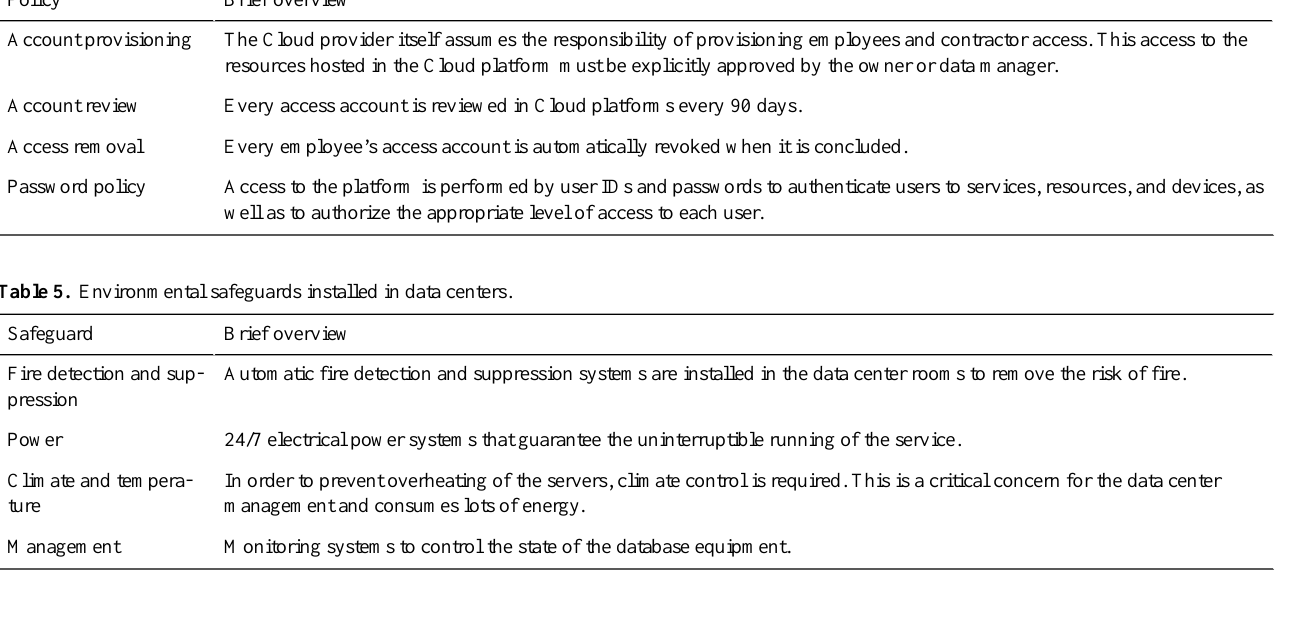
Table 4. Employee lifecycle policies of a Cloud provider platform. Brief overviewPolicy